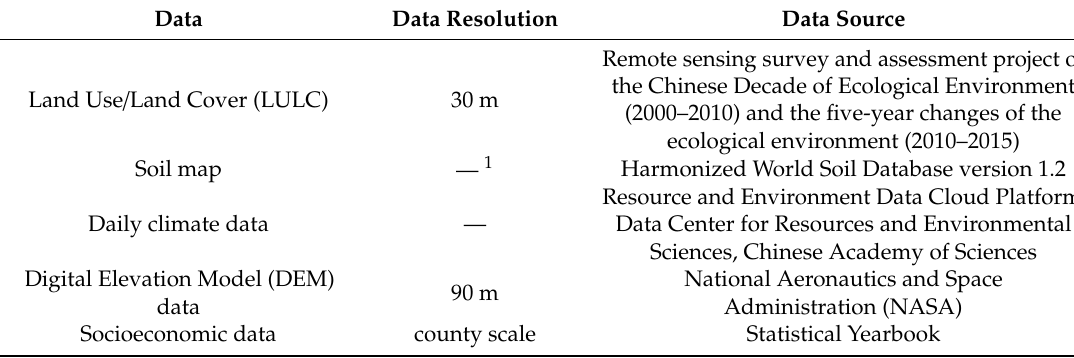
Table 2. Sources of principal